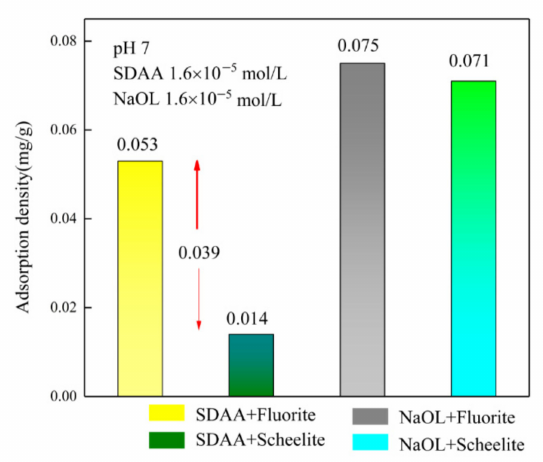
Figure 5. The adsorption density of SDAA and NaOL on the surfaces of the two minerals.